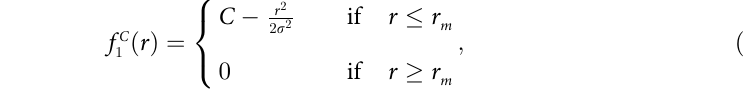
ffiffiffiffiffiffiffiffiffiffiffiffiffiffiffiffiffiffiffiffiffiffiffiffiffiffiffiffiffiffiffi n max